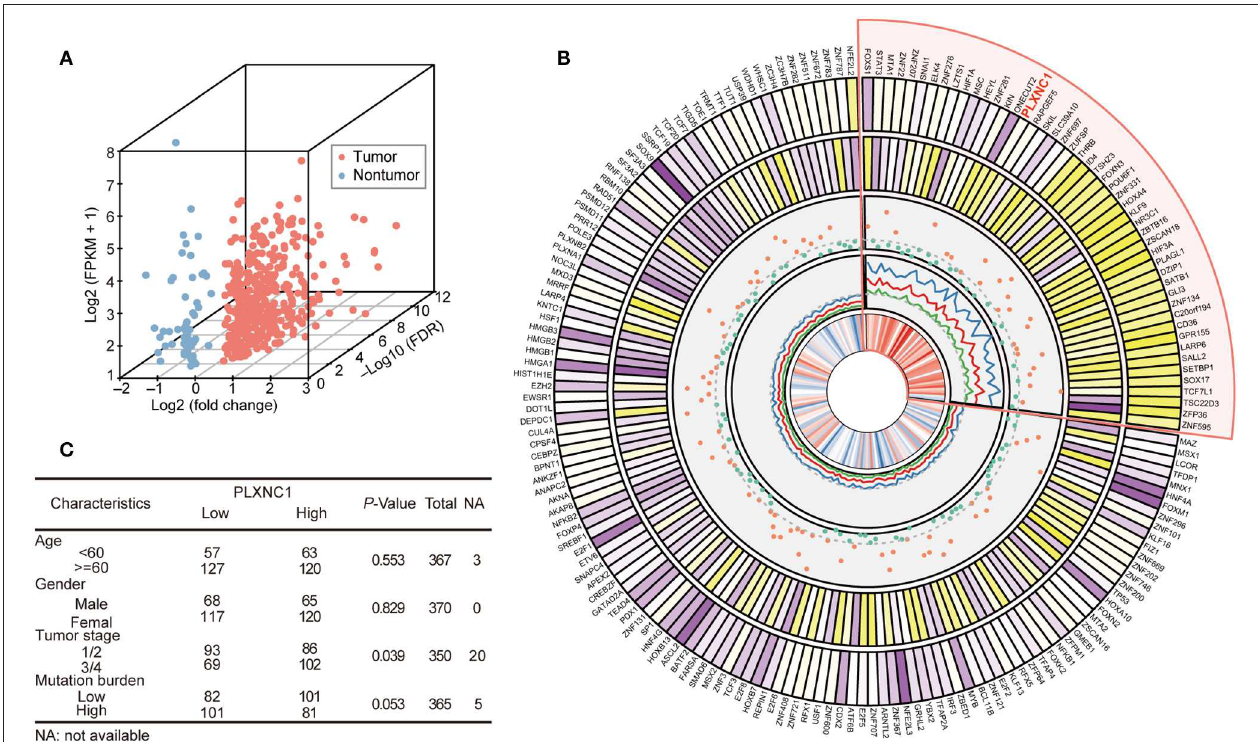
FIGURE 1 | Differentially expressed transcription factors predict a patient’s overall survival in TCGA-STAD cohort. (A) Three-dimensional scatter plot generated from the differential expression profiles of TCGA-STAD 27 paired gastric tissue. (B) The circled diagram of differentially expressed TF genes in TCGA-STAD cohort. In the figure comprised of five tracks, the first track refers to the average expression level (log2 transfer) of TFs; the second track indicates the fold change of differential expression analysis of TFs in the STAD paired tissue dataset; the third track shows the P -value (–log10 transfer) of log-rank test for each TF; the fourth track represents the hazard ratio value of univariate-cox model (HR value and it’s 95% CI (lower and upper) were both highlighted as red, blue, and green ligatures, respectively); the last track displays the correlation coefficients between tumor stage and TF expression level. The darker color indicates a higher quantitative value to distinguish TFs. The sector with light red shows the high-risk TFs, which indicate poorer outcomes for GC patients. (C) Correlation of clinicopathological features with tumor PLXNC1 expression level in TCGA-STAD cohort.